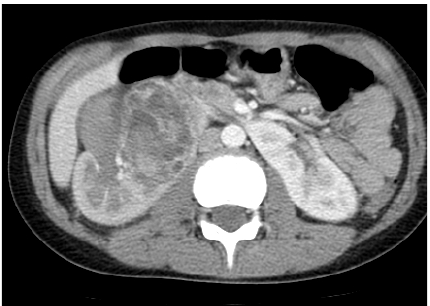
Figure 1: Abdominal computed tomography revealed an ill-defined tumor arising from the lower pole of the right kidney.